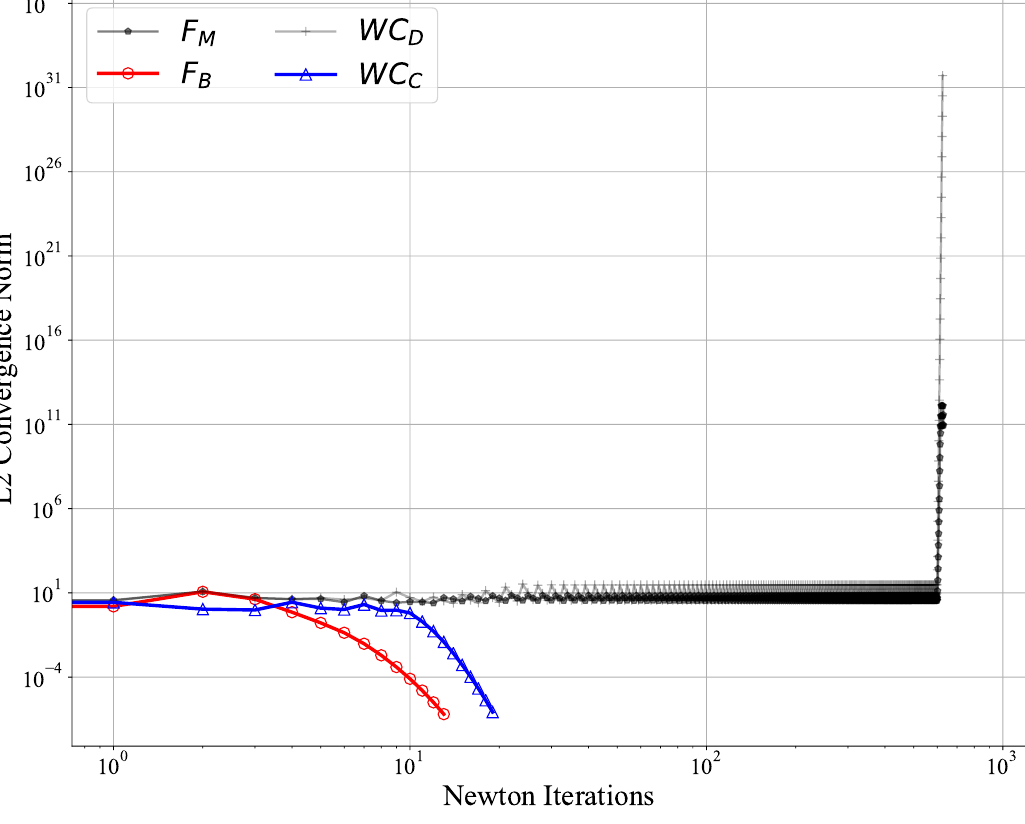
Figure 6. Comparison of convergence for Waller Creek test case with ( F M , WC O ) and without ( F B , WC C ) an artificial sharp-transition cross-section that causes